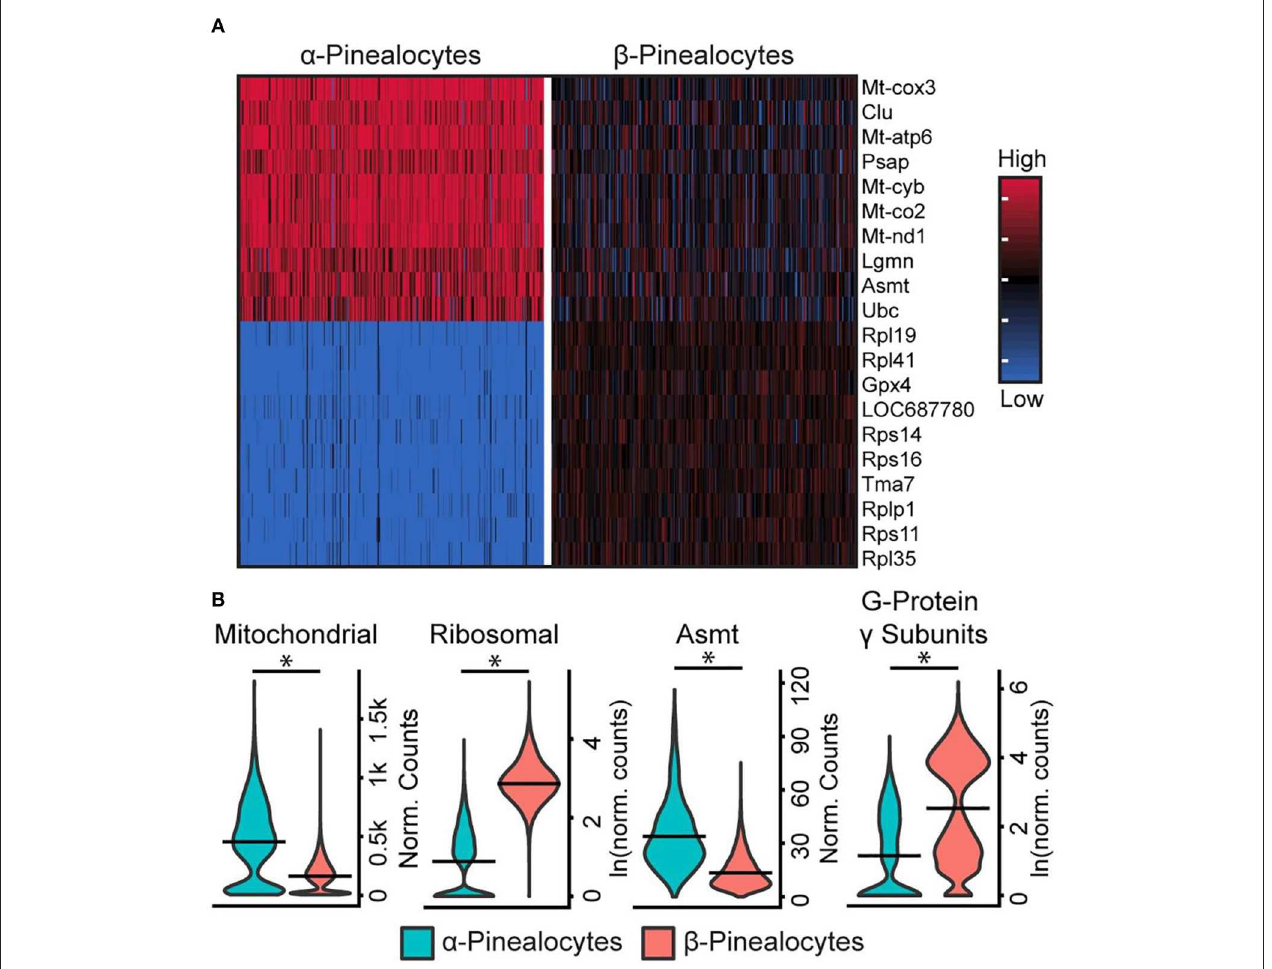
FIGURE 4 | scRNA-seq reveals two transcriptionally distinct pinealocyte populations. (A) A heatmap of expression values for the top 10 most differentially expressed genes (by effect size) for α - and β -pinealocytes. Values are Z-scores of counts calculated between all cells of both cell types. Each column represents one cell: random samples of 250 cells per cell type are presented. (B) Violin plots of expression distribution differences between two pinealocyte subtypes for three functional groups and one gene, Asmt . Y-Axis is either normalized counts or natural log (ln) of normalized counts. Horizontal lines represent the mean. * p < 0.001, Wilcoxon rank sum test. All cells from each subtype are included ( α -pinealocyte, n = 275; β -pinealocyte, n = 4,822). Mitochondrial group includes differentially expressed mitochondrial OxPhos genes ( p < 0.05, N = 12, fold change ≥ 2.0), ribosomal group includes top 20 most differential ribosomal genes by effect size ( p < 0.05, fold change ≥ 2.0),